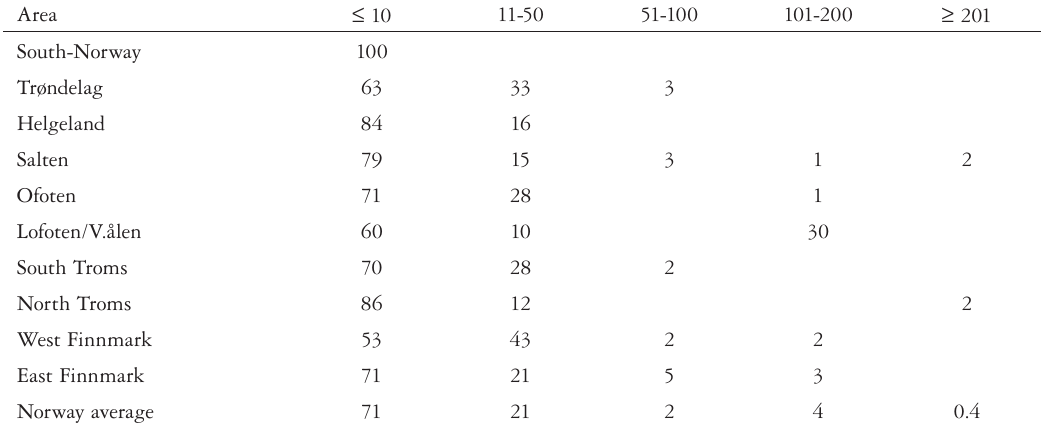
Table 2. Proportion (%) of households with reindeer as part of livestock in 1875 distributed after number of reindeer. (Source: Agricultural Census and National Census, 1875,